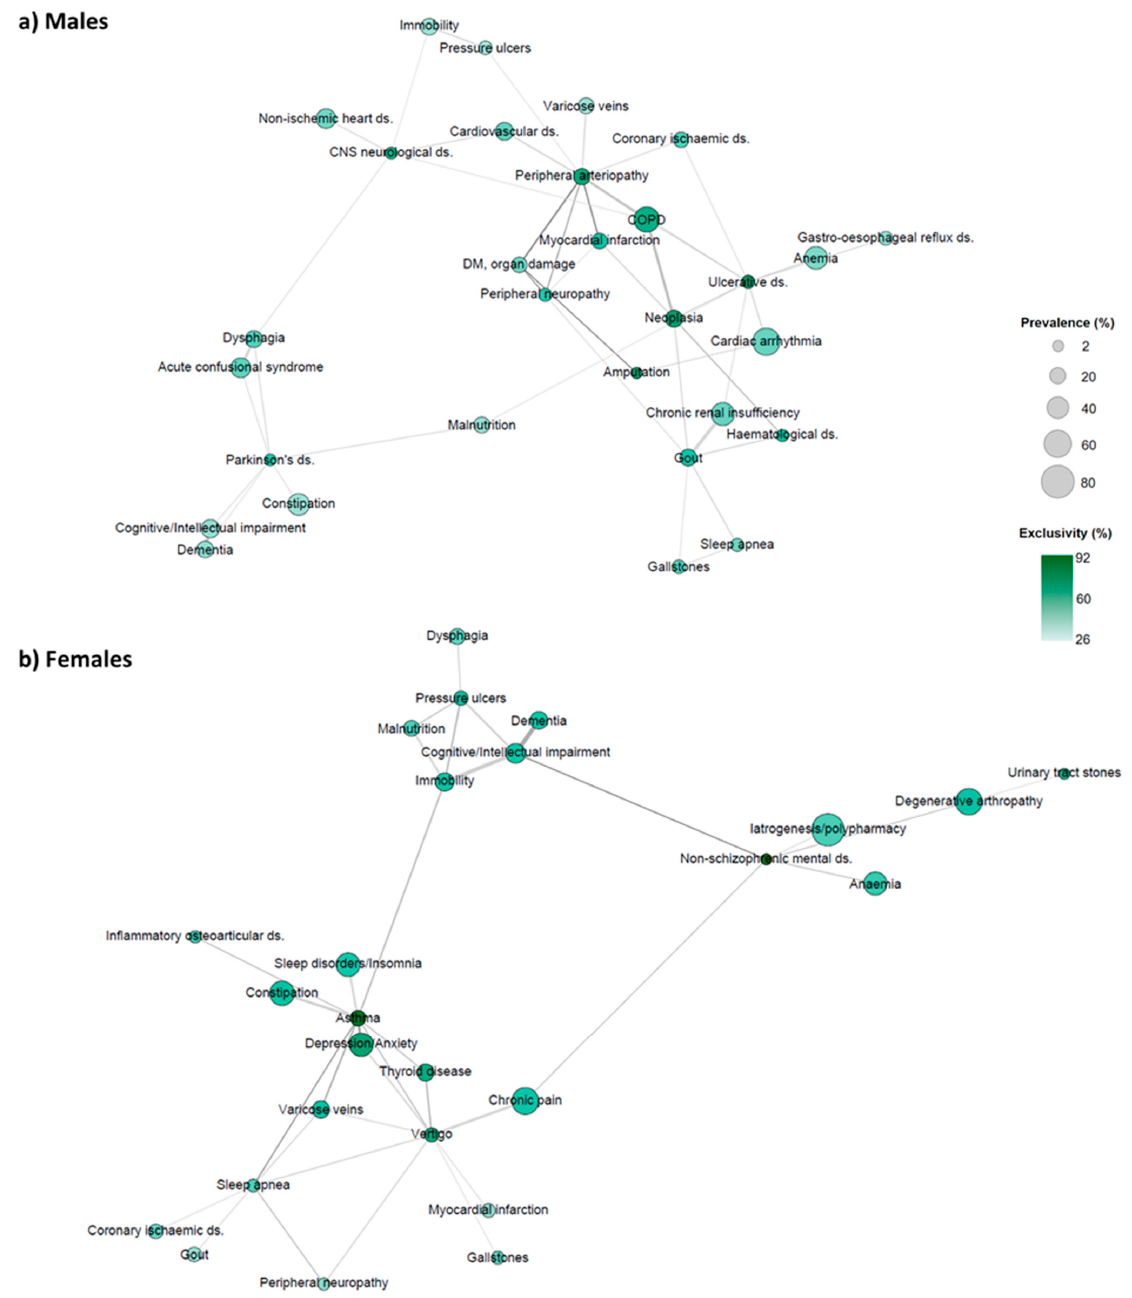
Figure 2. Network visualization of chronic conditions and geriatric syndromes using the ForceAtlas2 graph layout algorithm. Data was filtered by >2% prevalence and by >2 pairwise O/E ratio. The main components of networks are nodes (chronic diseases/geriatric syndromes) and edges (coexistence of diseases or syndromes) that connect nodes in the network. Edge width is proportional to the prevalence of each chronic disease pair. Edge color is proportional to the Observed/Expected (O/E) ratio of the pair of diseases (a darker edge means a higher O/E ratio). The size of the nodes is proportional to the prevalence of the disease. The intensity of the color is proportional to the sex exclusivity. CNS: central nervous system; COPD: chronic obstructive pulmonary disease; DM: diabetes mellitus; ds: disease. Figure 2a includes male patients; Figure 2b includes female